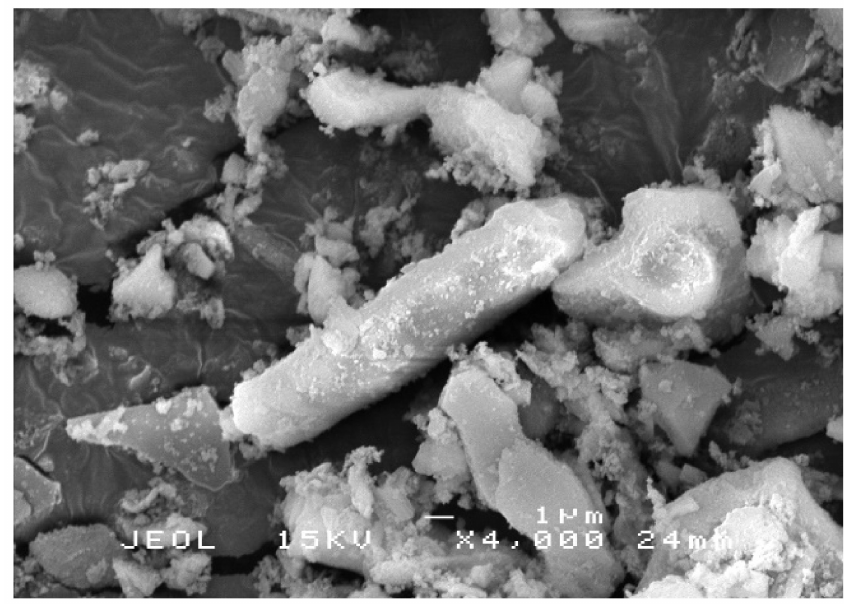
Figure 2. SEM image of RHA structure after